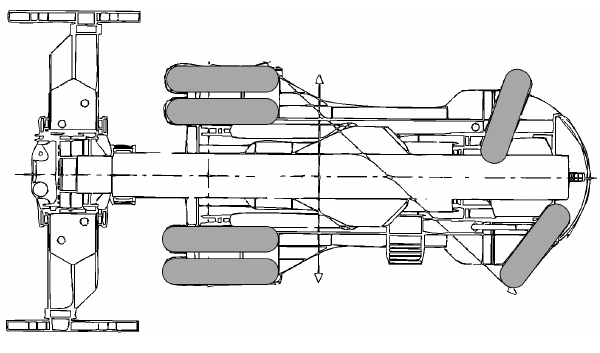
Figure 1. Plan view of a reach stacker. Table 2. Characteristics of design of a reach stacker.